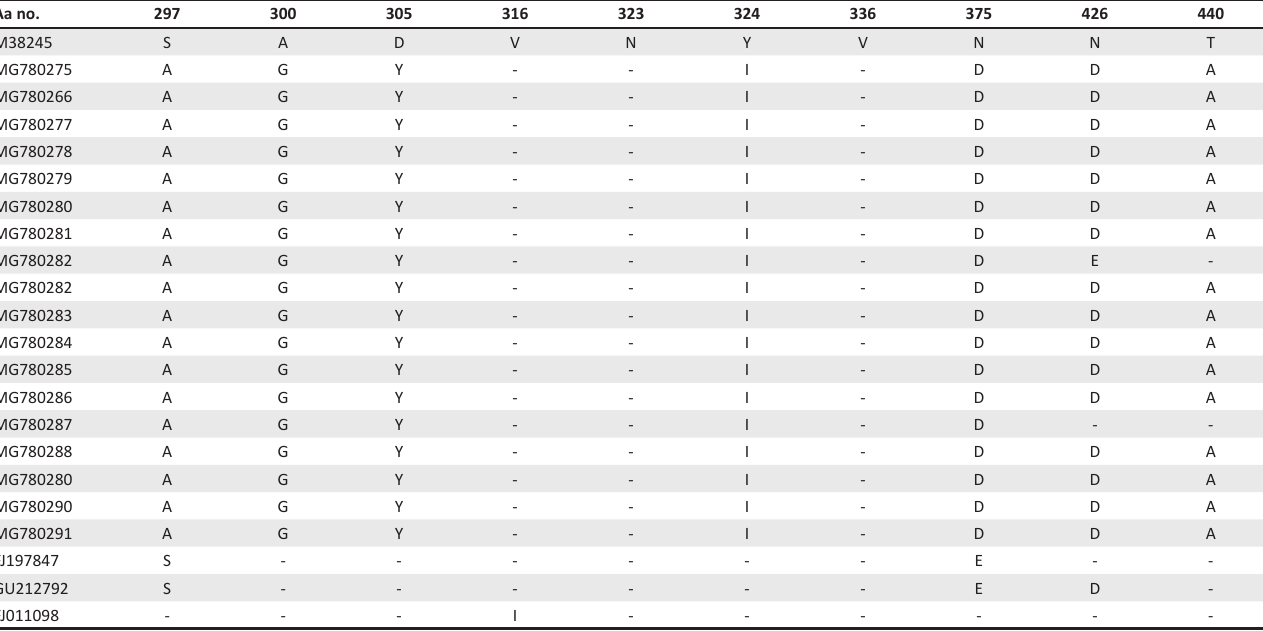
TABLE 3a: Amino acid changes in VP2 partial gene of canine parvovirus-2a, canine parvovirus-2b and canine parvovirus-2c. Aa no. 297